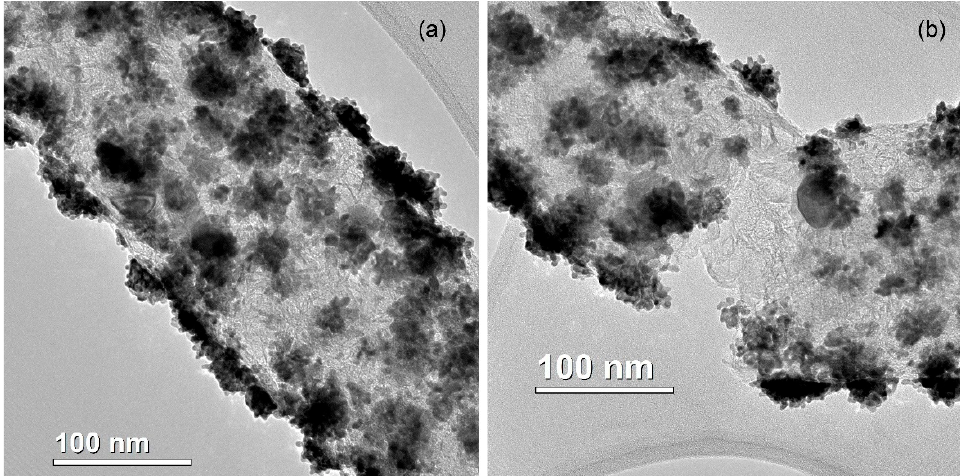
Figure 10. CNF with crystalline structure: ( a ) BF TEM image; ( b ) STEM HAADF image; and ( c – f ) elemental mapping for sample 6 .